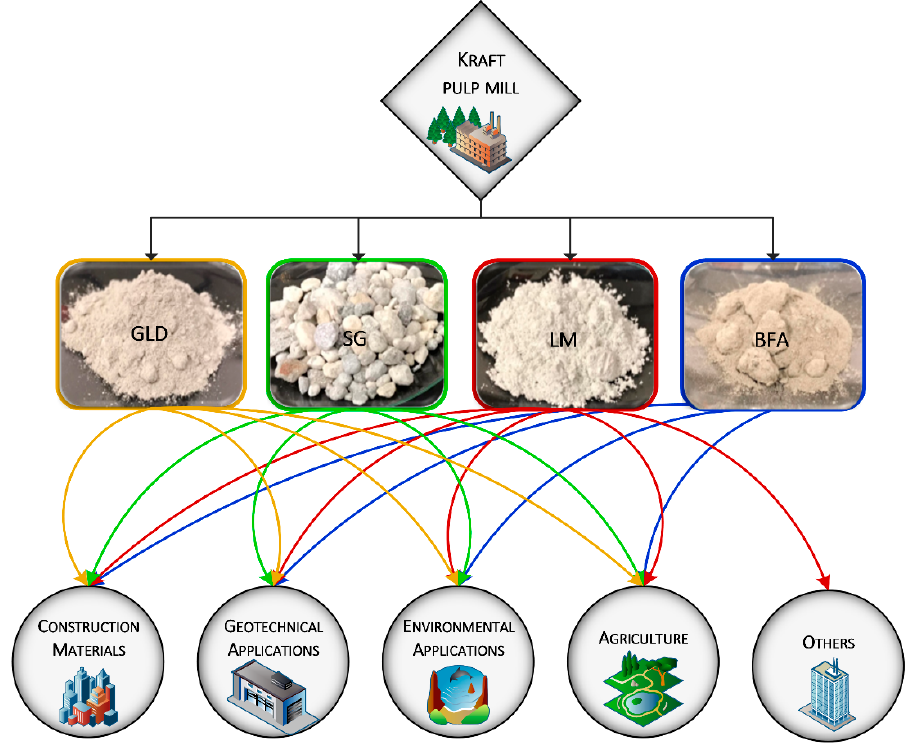
Figure 2. Categories of the potential applications for inorganic wastes from the pulp industry.